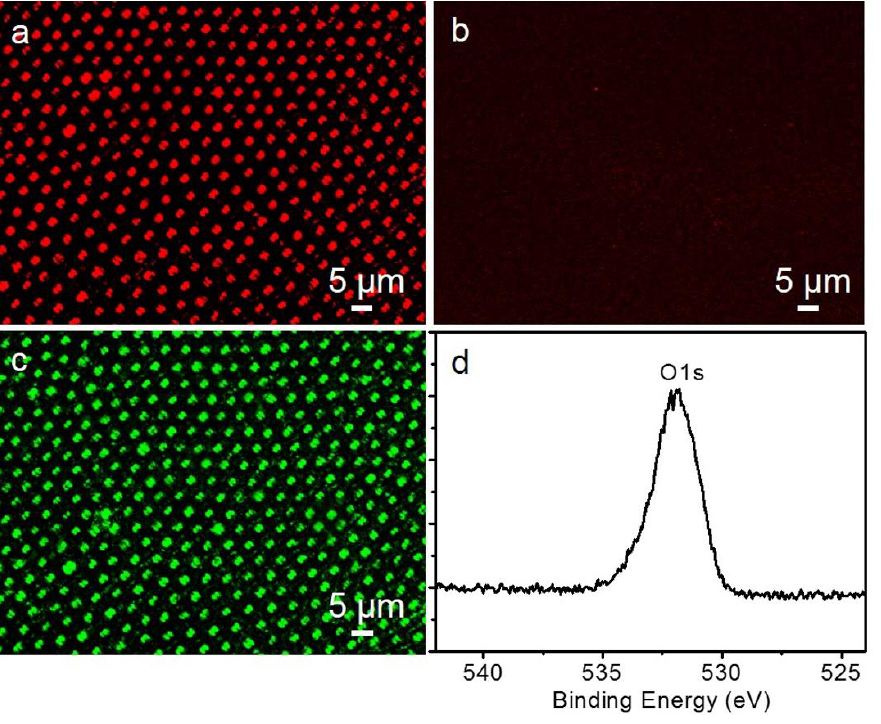
Figure 2. Confocal laser scanning microscopic (CLSM) images of porous polystyrene (PS) film ( a ) with and ( b ) without modification of polyacrylic acid (PAA) after immersion in dichlorotris(1,10-phenanthroline)ruthenium (II) hydrate (CAR) dye solution, ( c ) poly(diallyldimethylammonium chloride) (PDDA)-contained film after immersion in the FDS dye solution, and ( d ) XPS spectrum of porous PS film ( a ).